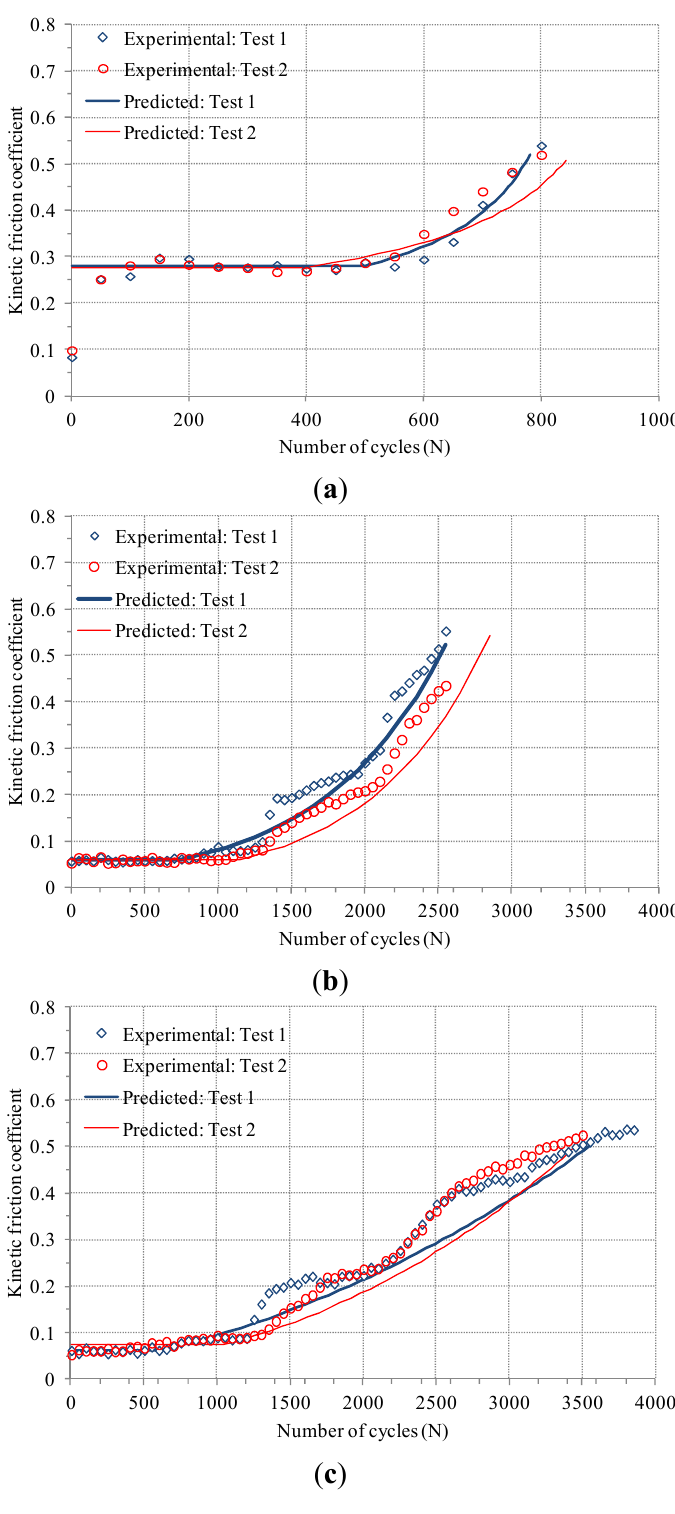
Figure 7. Direct comparison between predicted and measured friction coefficient evolutions: ( a ) Conventional (AISI 52100); ( b ) Si 3 N 4 ; and ( c ) ZrO 2 balls. Contact pressure between a ball and a flat specimen has an influence on friction and wear rate of an electro-deposited coating. Apparent relation between the maximum contact pressure and the steady-state friction coefficient was not found in this study due to lack of experimental data. This